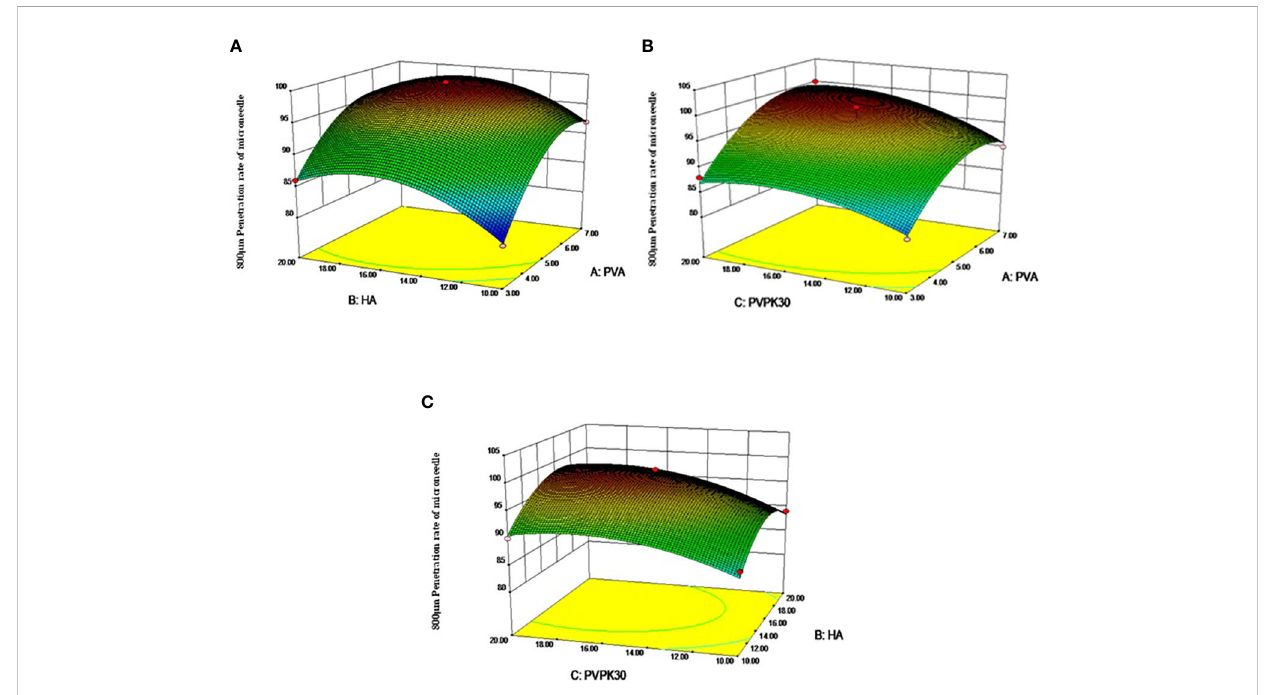
FIGURE 2 Response surface diagram and contour diagram of the interaction of various factors of microneedle prescription on the in fl uence of microneedle preparation. (A) PVA and HA interactive response surface, (B) PVA and PVPK30 interactive response surface, (C) PVPK30 and HA interactive response